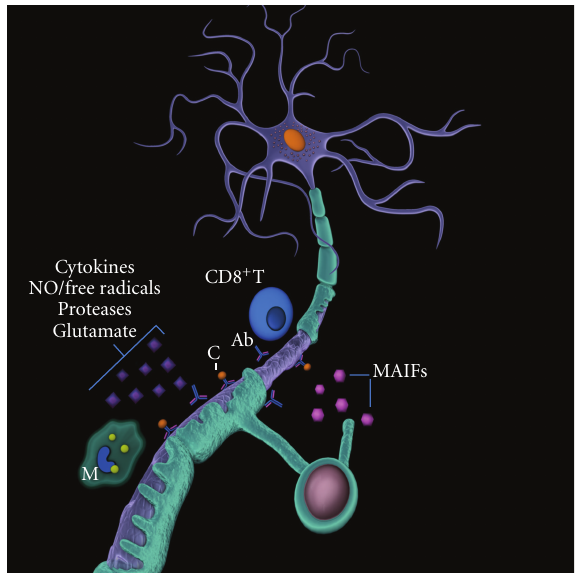
Figure 1: The mechanisms of neuroaxonal damage in multiple sclerosis. Legend: NO: nitric oxide; M: macrophage; C: comple- ment; Ab: antibody; CD8 + T: CD8 + T-lymphocyte; MAIFs: myelin- associated inhibitory